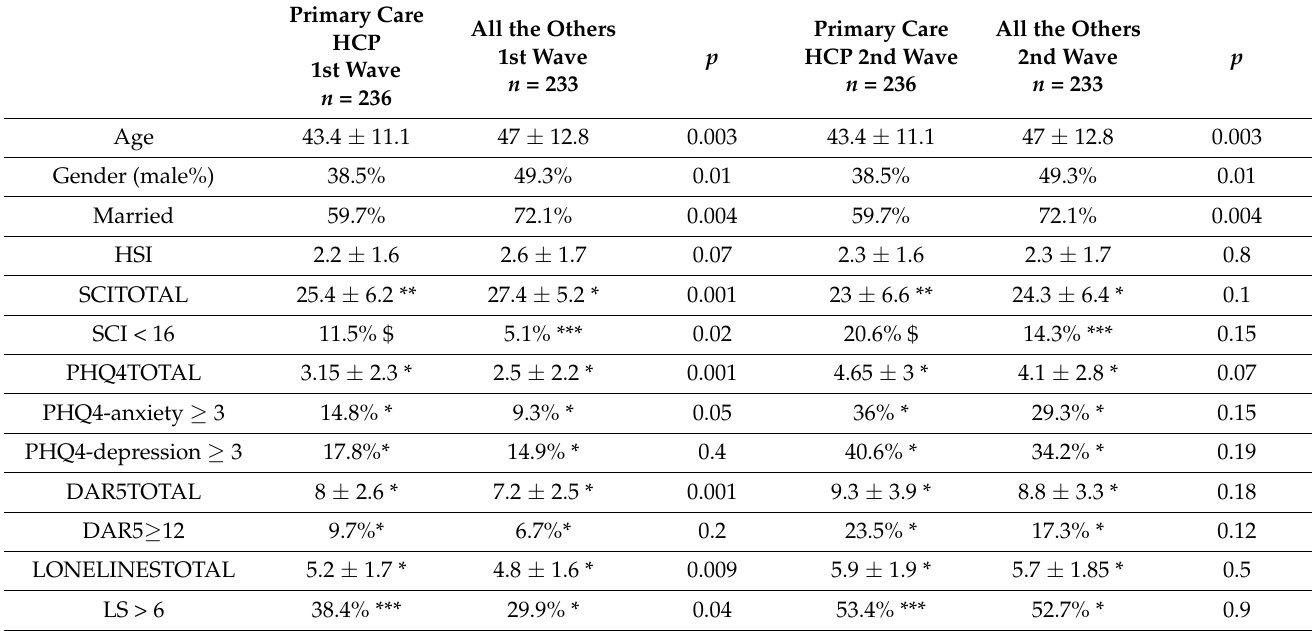
Table 4. Comparison between primary care HCPs with all the others participants during the 1st and 2nd wave.